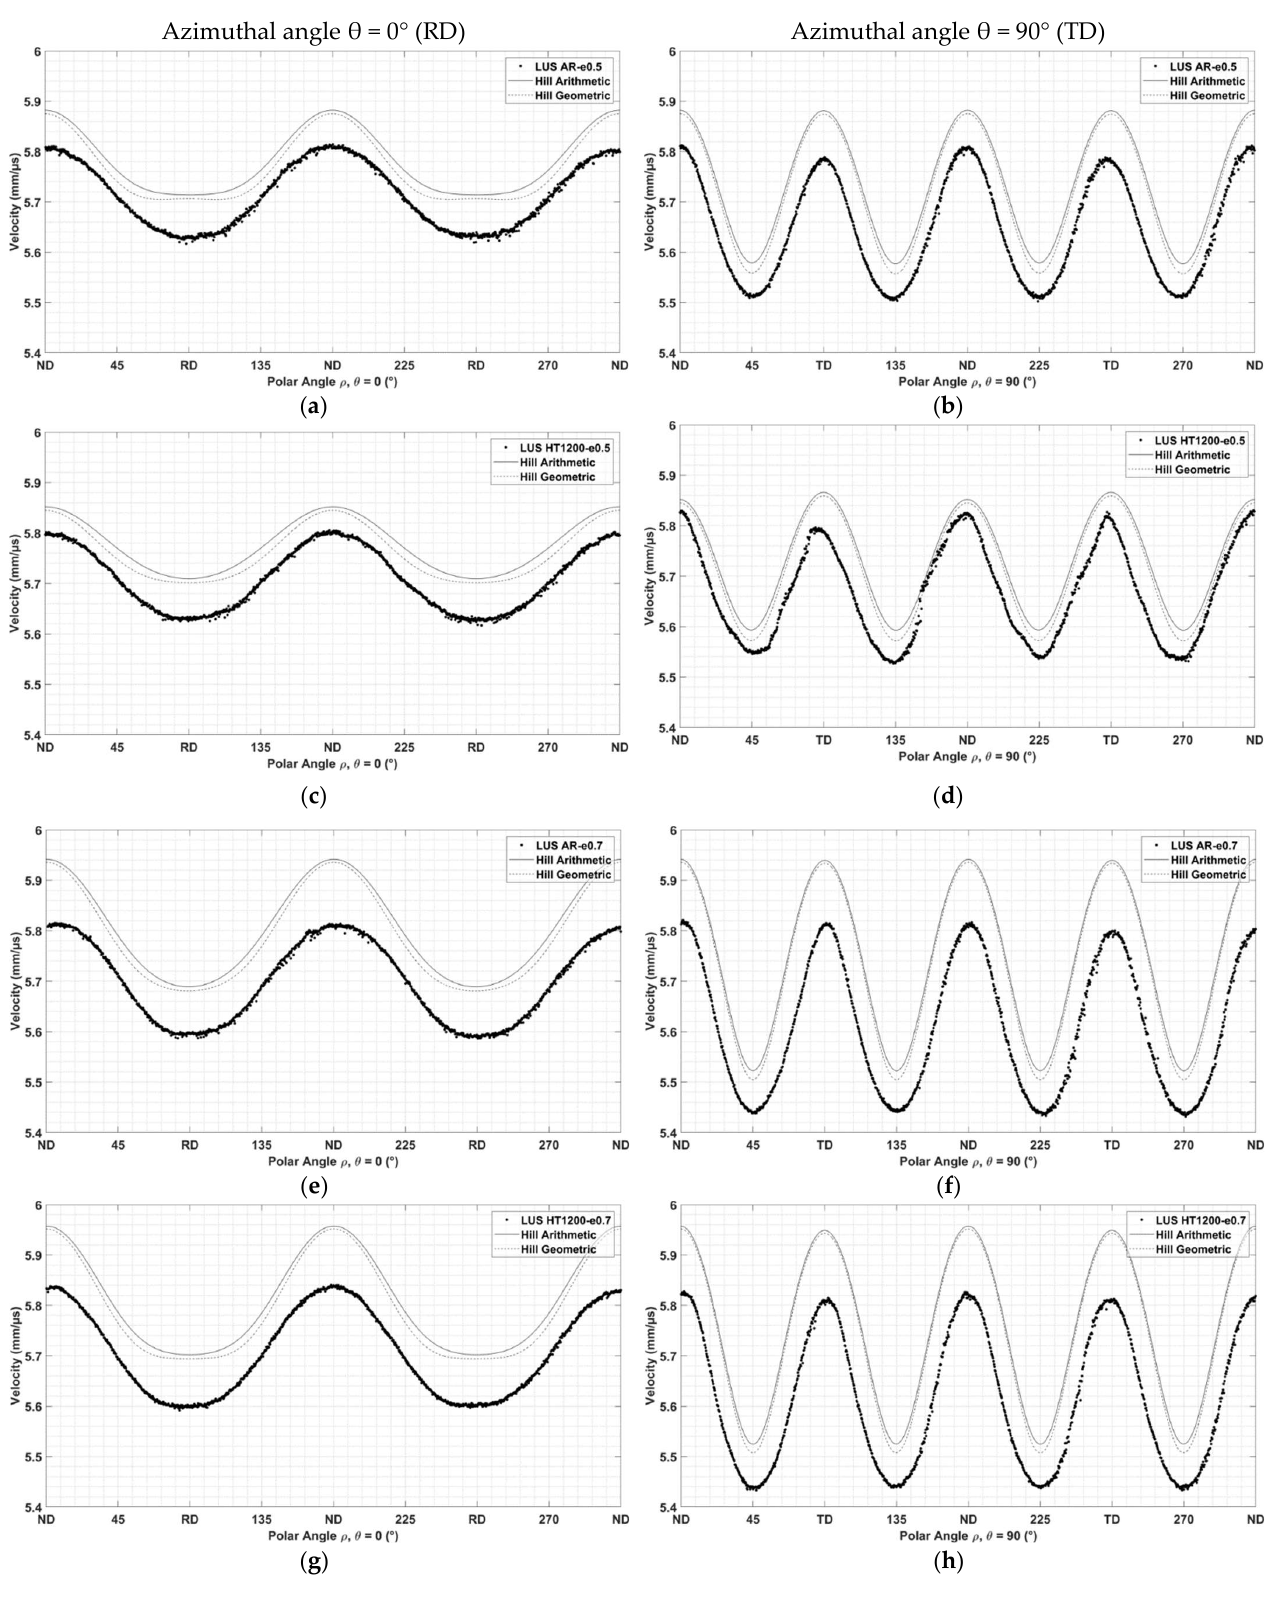
Figure 8. LUS measured velocity versus the polar angle for all the cylindrical samples where (a , b) represents the as-received 50 % reduced, (c , d) the heat treated 50 % reduced, (e , f) the as-received 70 ( a , b ) represents the as-received 50% reduced, ( c , d ) the heat treated 50% reduced, ( e , f ) the as-received % reduced, and (g , h) the heat treated 70 % reduced sample. The graphs also display the EBSD 70% reduced, and ( g , h ) the heat treated 70% reduced sample. The graphs also display the EBSD calculated velocity using Hill arithmetic and the geometric approximation. calculated velocity using Hill arithmetic and the geometric